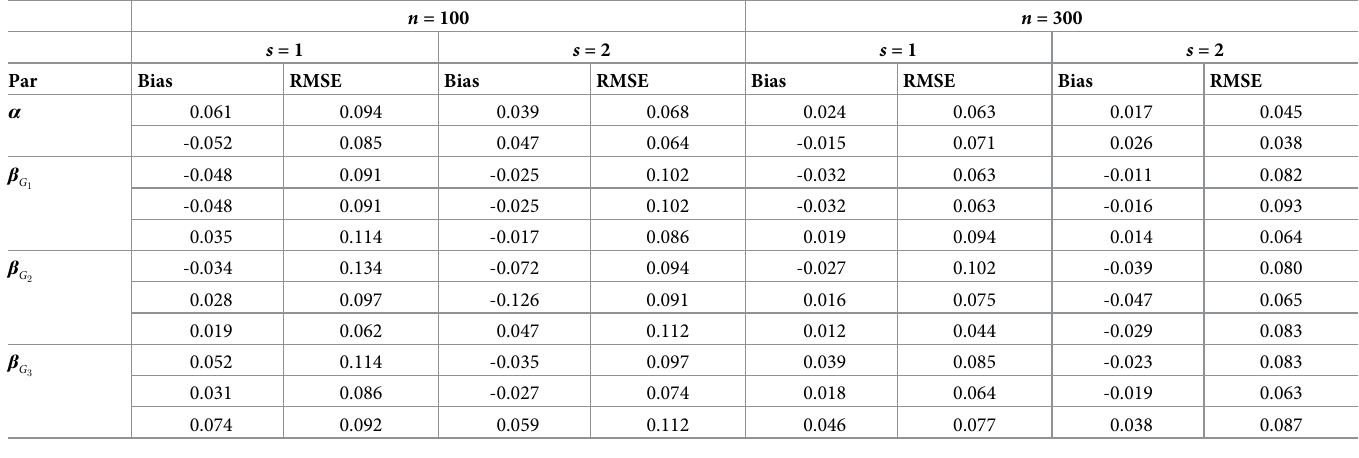
Table 1. Estimate results under prior